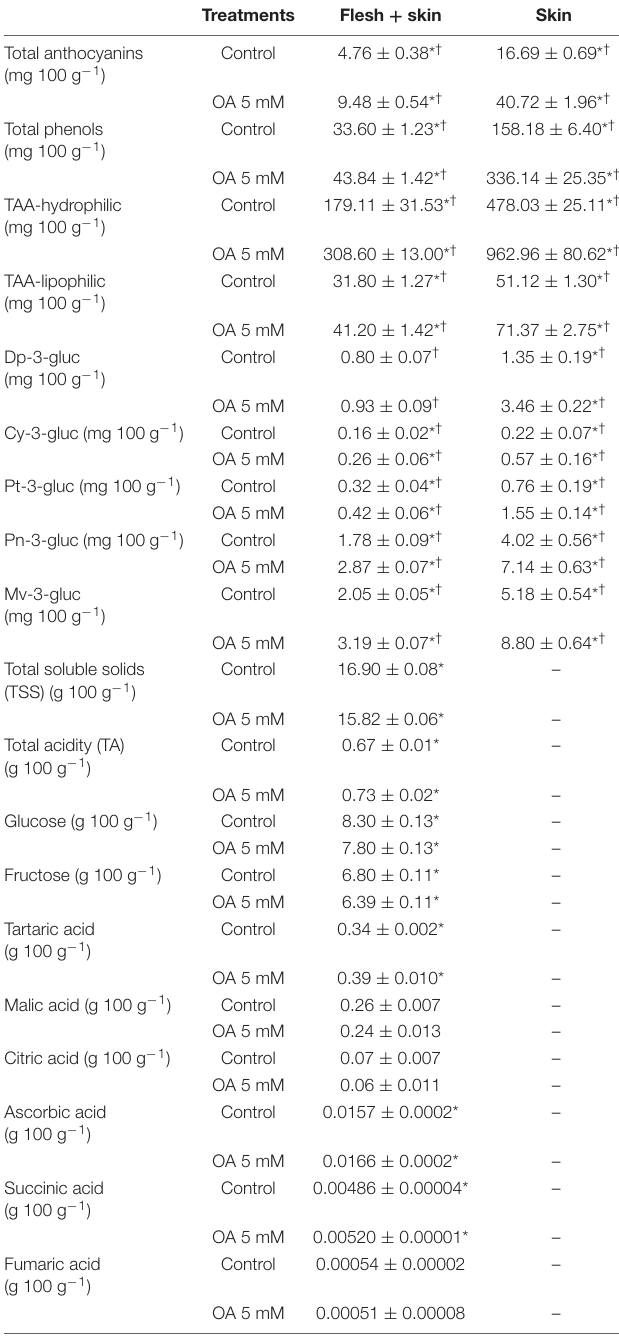
TABLE 2 | Bioactive compound content (total anthocyanins and total phenols), hydrophilic (H-TAA) and lipophilic (L-TAA) total antioxidant activity, individual anthocyanin content (dp-3-gluc; delphinidin 3-glucoside, cy-3-gluc; cyanidin 3-glucoside, pt-3-gluc; petunidin 3-glucoside, pn-3-gluc; peonidin 3-glucoside and mv-3-gluc; and malvidin 3-glucoside), total soluble solids (TSS), total acidity (TA), and individual sugar (glucose and fructose) and organic acid content (tartaric acid, malic acid, citric acid, ascorbic acid, succinic acid, and fumaric acid) in whole fruit (flesh + skin) or skin tissue of control and 5 mM OA-treated table grapes at